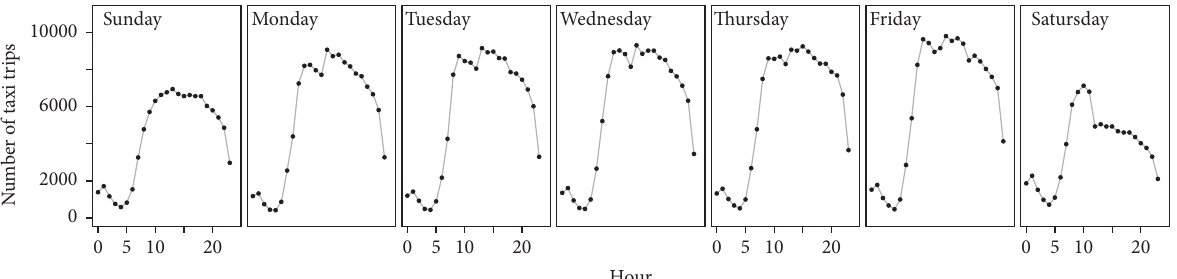
Figure 2: Hourly dynamics of the number of taxi trips on different days of a week.